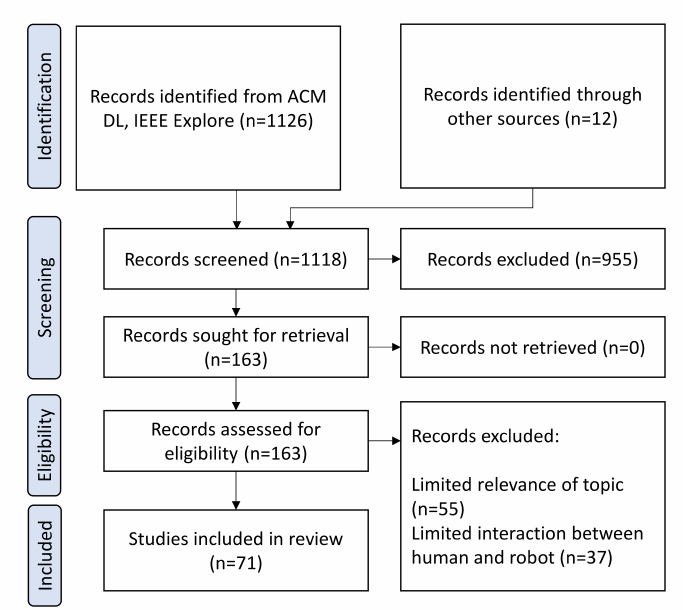
Figure 1. PRISMA flow diagram of the selection